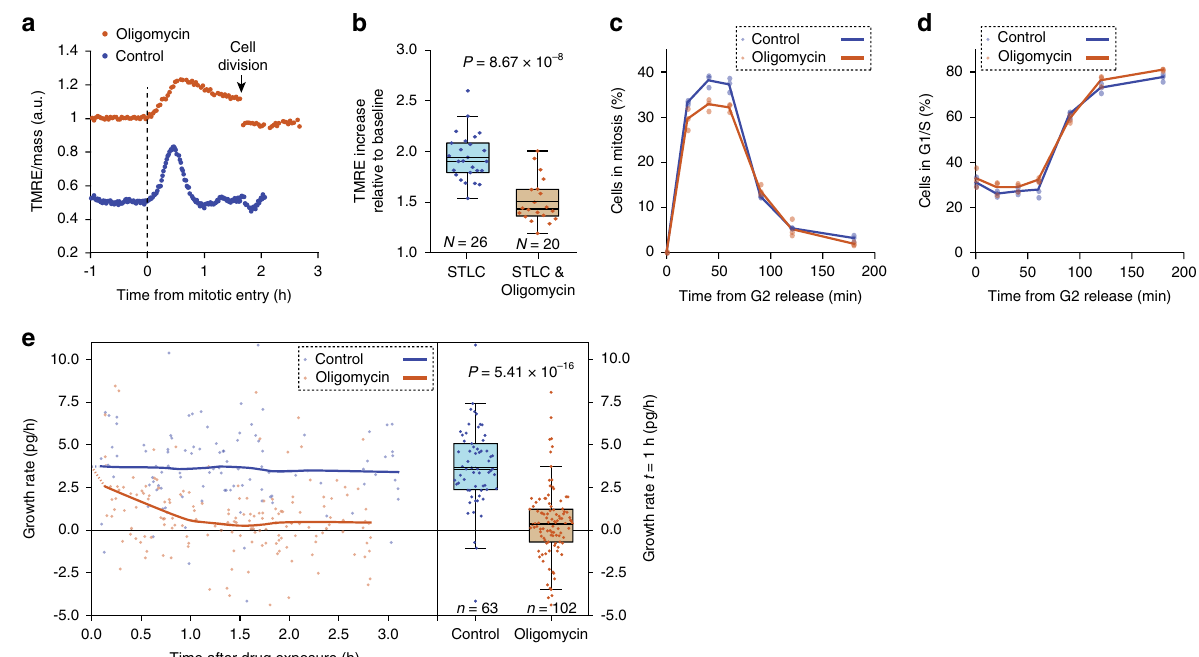
Fig. 3 Mitochondrial ATP synthase activity is required for cell growth, but not for cell division. a Mass-normalized TMRE trace for control (blue) and 1 µ M oligomycin-treated (brown) L1210 cell around cell division. Both control and oligomycin-treated cells proceed through mitosis, but display distinct TMRE dynamics. b Quanti fi cations of the TMRE increase in mitosis following mitotic arrest with STLC in control and 1 µ M oligomycin-treated L1210 cells. Baseline refers to G2 TMRE levels. c Quanti fi cations of mitotic entry in control (0.1% v/v DMSO-treated) and 1 µ M oligomycin-treated L1210 cells. Cells were synchronized to G2, released and collected for cell cycle analysis at indicated timepoints. Treatments were started 15 min before releasing from G2 arrest. Each dot represents a separate culture ( n = 3). d Quanti fi cations of mitotic exit (appearance of G1 cells) for samples shown in ( c ). e Quanti fi cation of mass accumulation (growth) rate in individual control and 1 µ M oligomycin-treated cells. Each dot represents the growth rate of a single-cell. Quanti fi cations of the growth rates after 1 h drug exposure are shown on the right. In ( b , e ), boxplots depict the mean (small square), median (horizontal bar), interquartile range (IQR) (box), and 1.5× IQR (whiskers). Unpaired, two-tailed Student ’ s t test was used for statistical